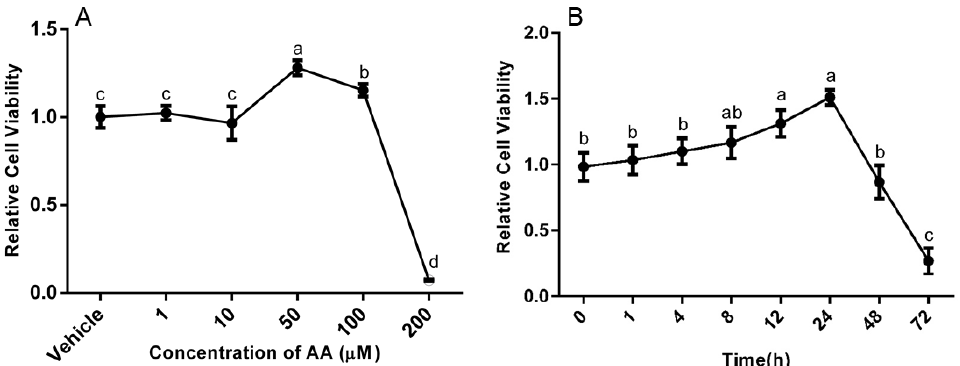
Figure 1. E ff ects of AA on the Viability in granulosa cells. Cells were challenged on Day 3 of culture with the doses given for 24 h in the left panel ( A ) or were challenged with 50 µ M AA or not with AA for the times given in the right panel ( B ). Viable cells were assessed using cck-8 assay kit after treatments and data are means ± SEM of three independent replicates. For each panel, means without common letters are significantly di ff erent ( p < 0.05).